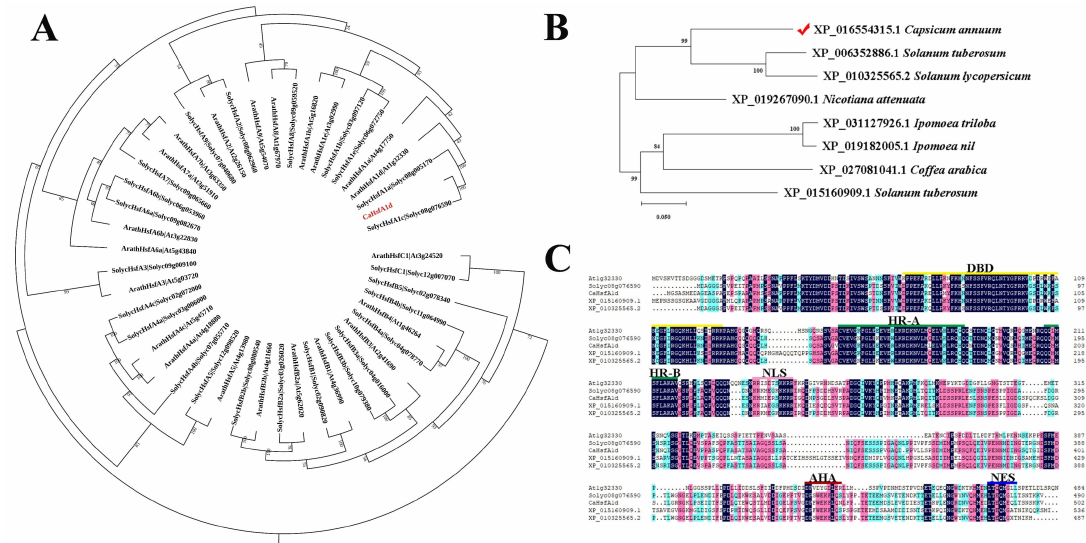
Figure 1. Sequence analysis of the CaHsfA1d protein. ( A ) Phylogenetic relationship of the CaHsfA1d with Arabidopsis (ArathHsfs) and tomato (SolycHsfs) Hsf proteins. The Hsf proteins of the Arabidopsis and tomato were downloaded from the Heatster (http: // www.cibiv.at / services / hsf / ). The neighbor-joining (NJ) phylogenetic tree was constructed using MEGA-X (http: // www.megasoftware.net / ) with the following parameters: Poisson model, bootstrap (1000 replicates), and pairwise deletion gaps. ( B ) Phylogenetic relationship of CaHsfA1d (XP_016554315.1) and Hsfs from other plant species. The protein sequence of CaHsfA1d was used to perform the BLASTP search in the database NCBI Protein Reference Sequences (https: // blast.ncbi.nlm.nih.gov / ). Eight HSF proteins were selected to construct the NJ phylogenetic tree by MEGA-X using the parameters in ( A ). ( C ) Multiple sequence alignment of Hsf proteins. Clustal Omega software (http: // www.clustal.org / ) was used to align the Hsf sequences using default parameters and the results were minor repaired by DNAMAN Version 9.0 (www.lynnon.com) software. The domains have been indicated. At1g32330 ( Arabidopsis thaliana , ArathHsfA1d), Solyc08g076590 ( Solanum lycopersicum , SolycHsfA1c), XP_015160909.1 ( Solanum tuberosum ), XP_010325565.2 ( Solanum lycopersicum